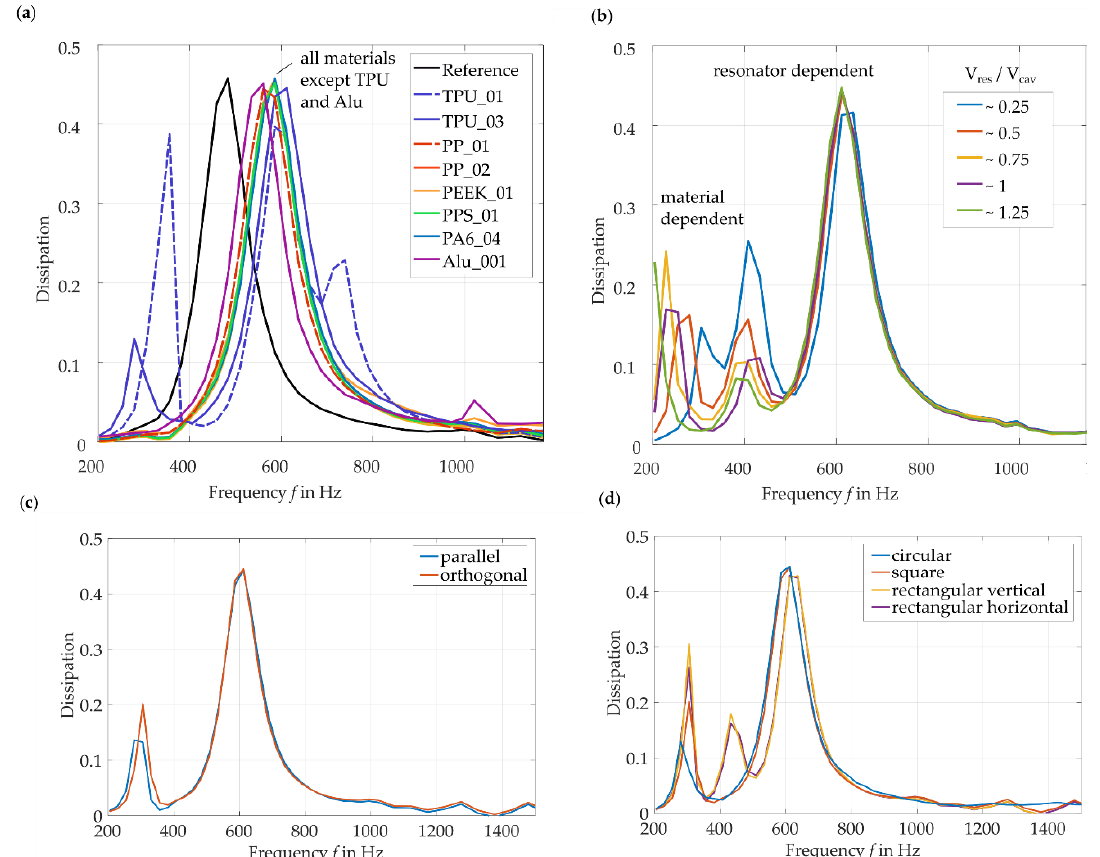
Figure 4. Comparisons of different aspects in the dissipation in dependence of ( a ) materials and thicknesses (constant back cavity and circular shaped cut-out), ( b ) the size of the back cavity in relation to the resonator volume (same material and rectangular shaped cut-out), ( c ) orientation of the back cavity in relation to the Duct (same material and circular shaped cut-out) and ( d ) the shape of the cut-out (TPU_03 and same back cavity size).